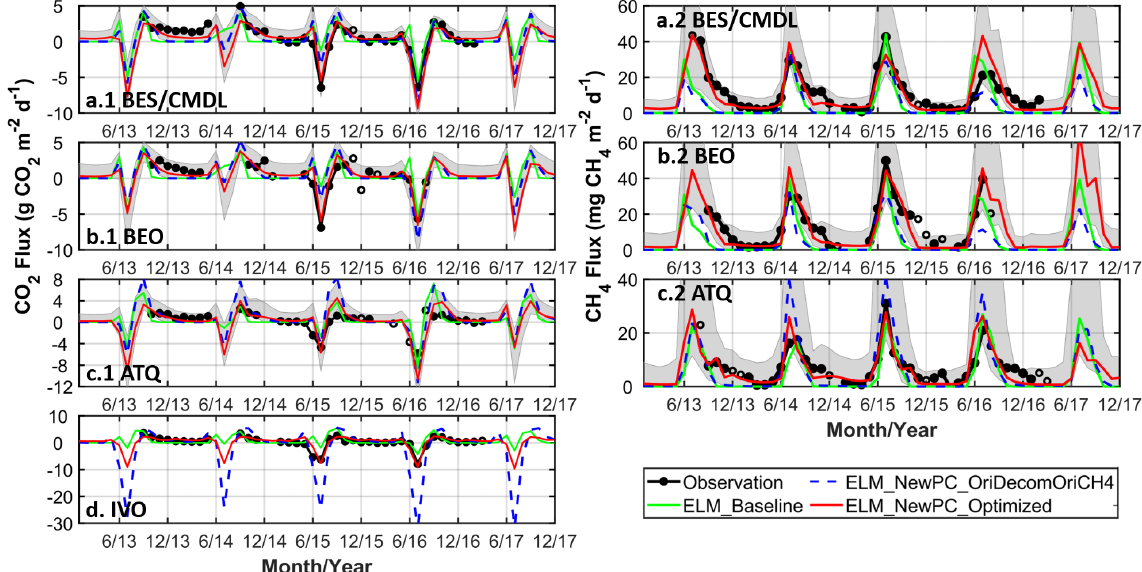
Figure 6. Observed and simulated monthly CO 2 (a.1, b.1, c.1, d) and net CH 4 (a.2, b.2, c.2) flux with the baseline model (ELM_Baseline) and the experiments with updated models (see Table 2 for the configuration for each experiment). Shaded gray areas indicate the minimum- to-maximum bound of simulations within the good performance zone (as shown in Fig. 5). Black open circles are observed monthly averages with the number of daily observations less than 10d, which are not used for the computation in Fig. 5. “ELM_NewPC_Optimized” means the best simulation for each site (red diamonds in Fig. 5). Intermediate results including “ELM_NewPC_OriDecomNewCH4” is included in Fig. S8 in the